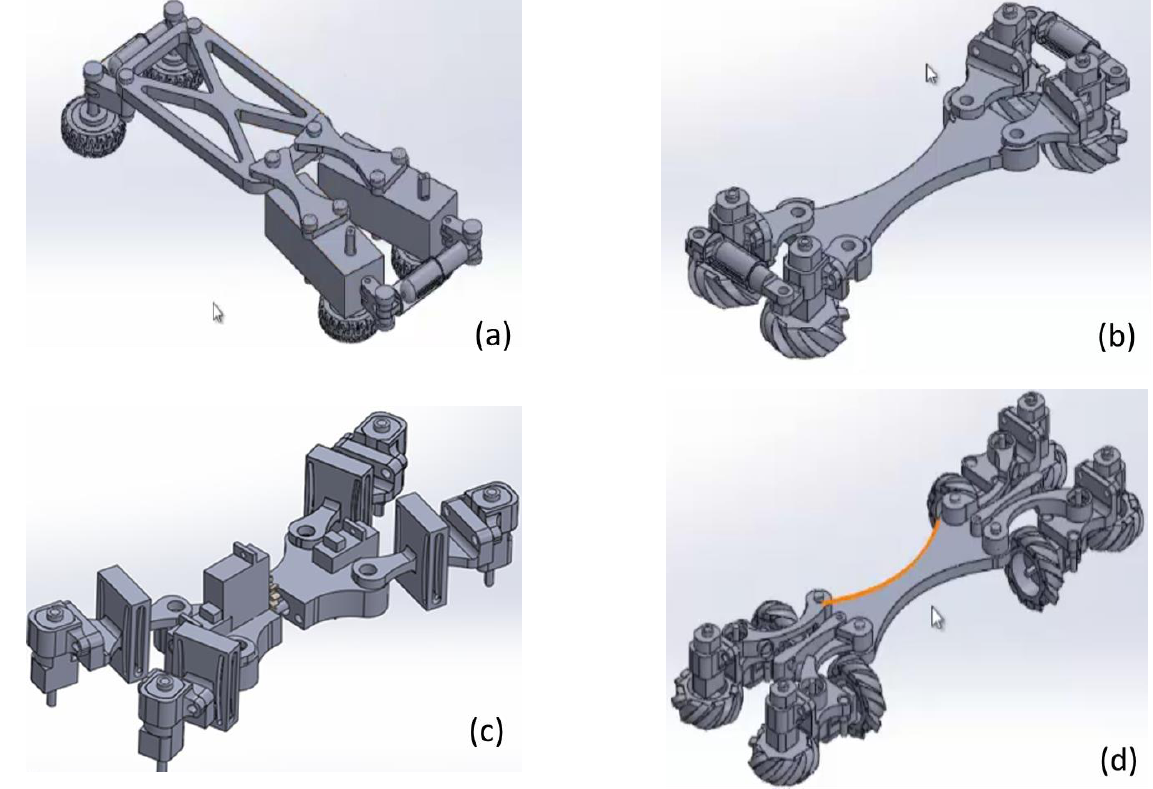
Figure 4. Mechanical design sketches; ( a ) Power transmission with two gear motors. ( b ) Power transmission with four micro gear motors and springs. ( c ) Mechanism with a servomotor to control the position of the robot. ( d ) Design with eight wheels in a horizontal and vertical position.